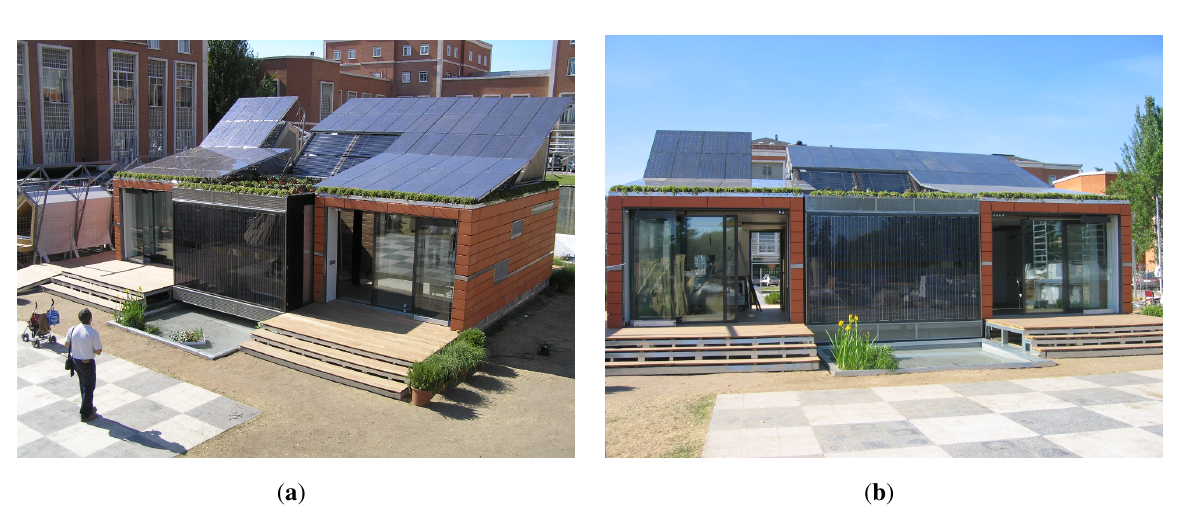
Figure 1. ( a ) Birds eye view and ( b ) south frontage of the “Magic Box” solar